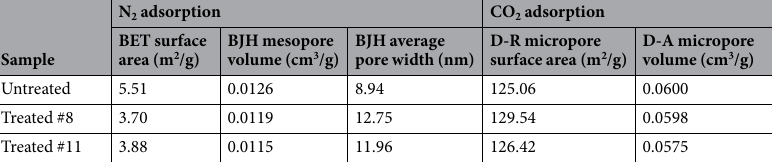
Table 4. Pore structure parameters for untreated and bioconverted